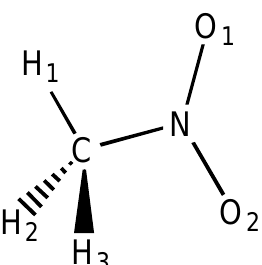
Figure 2. Atomic labeling used to distinguish the atoms in the nitromethane molecule.